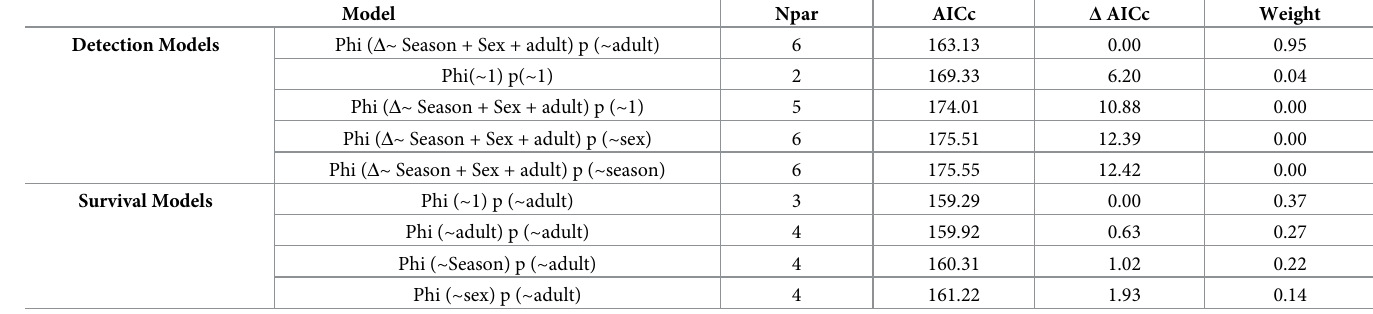
Table 4. Cormack-Jolly-Seber model selection results for Anna’s Hummingbirds, stratified by age, sex and season for the tagged population at Site 1 between Sep- tember